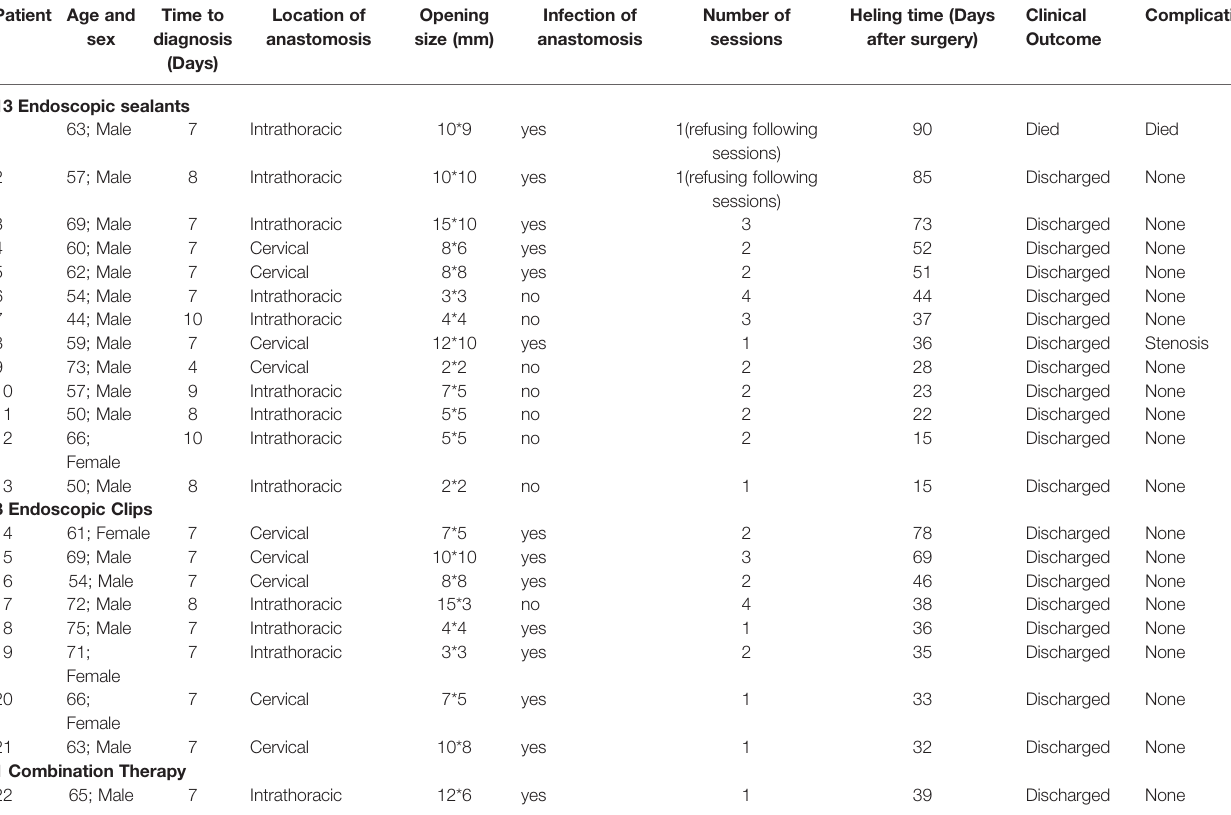
TABLE 3 | Characteristics of EAL of the 22 study patients who underwent systematic endoscopic intervention. Patient Age and sex